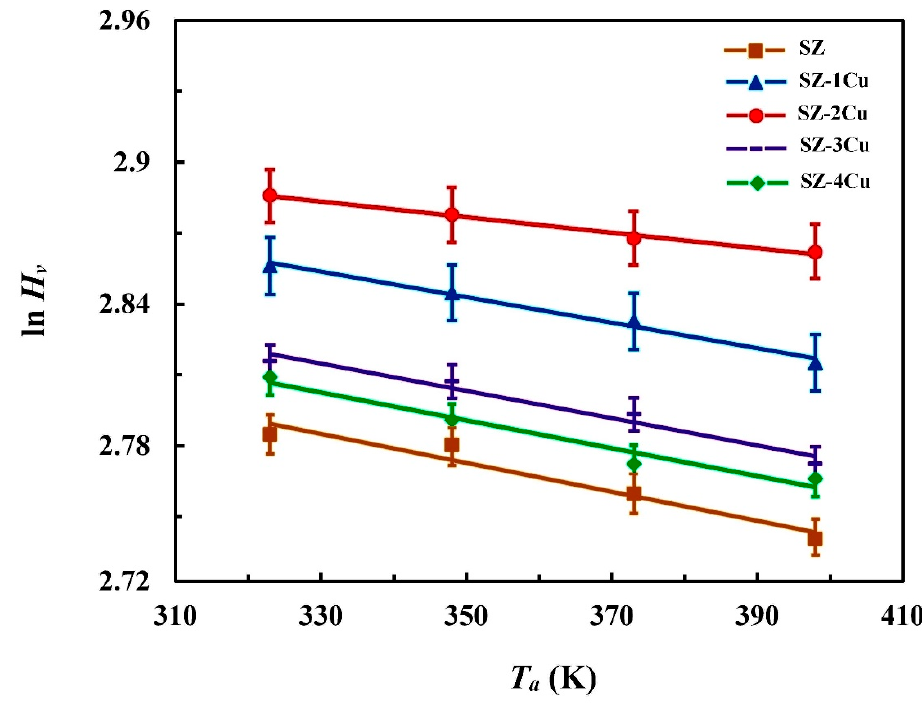
Figure 7. ln H v versus aging temperature, T a , for all the studied alloys.